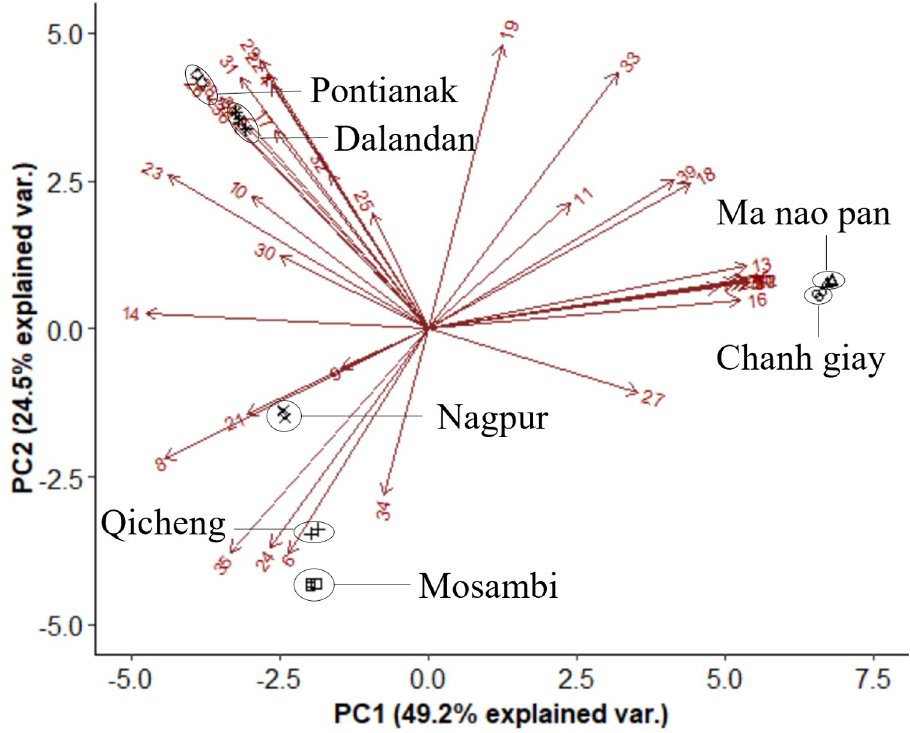
Fig 3. Biplots of identified non-volatile secondary metabolites in peel extracts of seven Asian citrus varieties. Numbers on the biplots correspond to Table